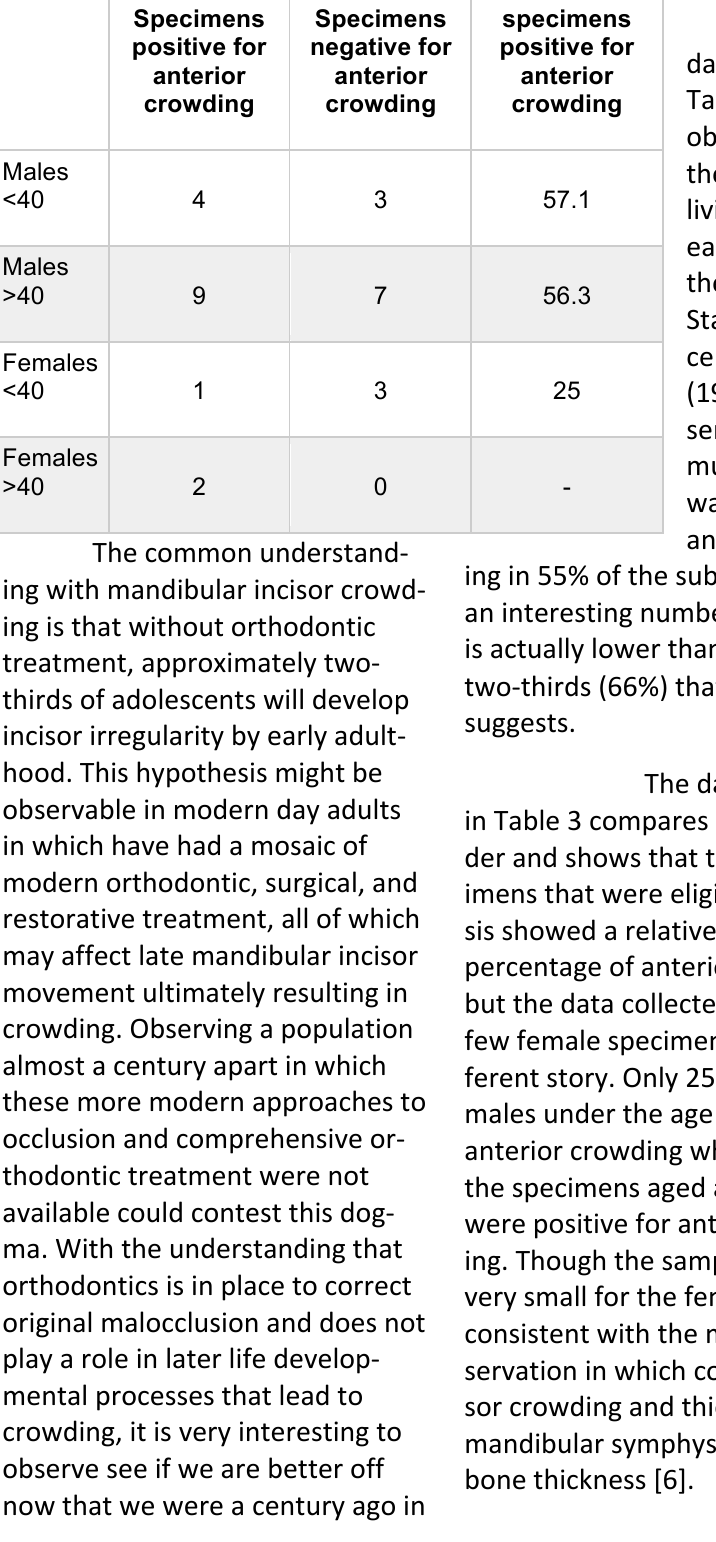
Specimens positive